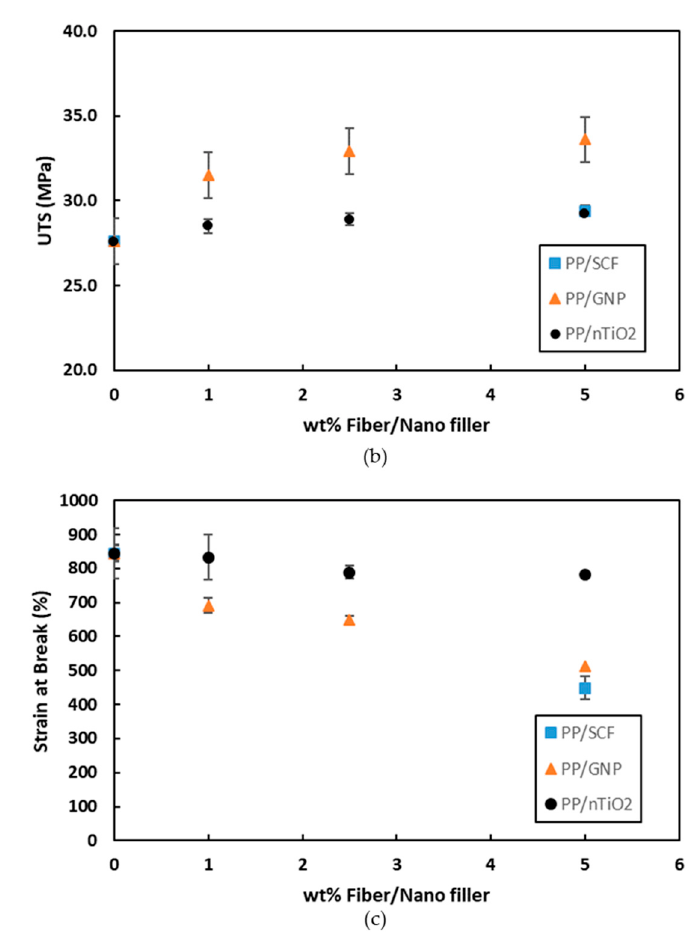
Figure 10. Mechanical properties of PP composites with different fillers ( a ) Tensile modulus, ( b ) Ultimate tensile strength (UTS), and ( c ) Strain at